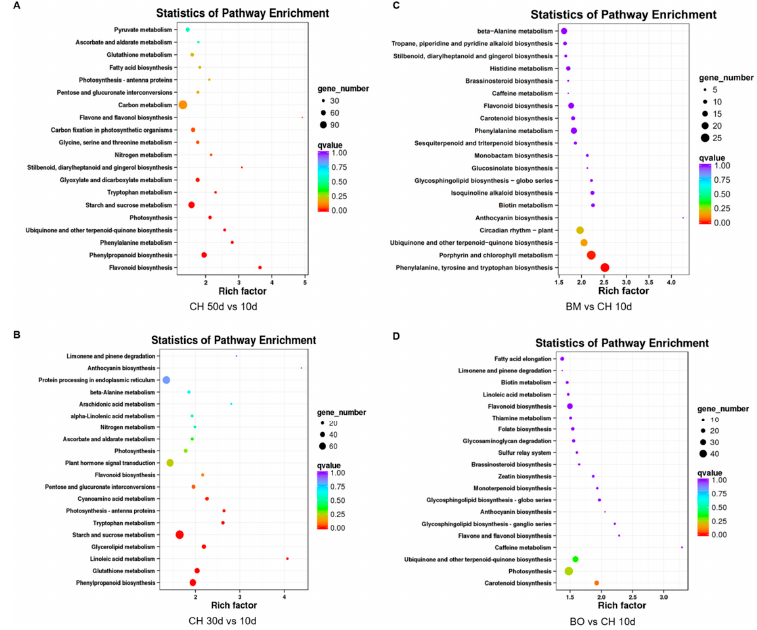
Figure 5. (replaced) Enrichment of KEGG pathways of differentially expressed unigenes (DEUs) in transcriptome comparisons between 50-day and 10-day leaves of CH ( A ), between 30-day and 10-day leaves of CH ( B ), between 10-day leaves of BM and CH ( C ), and between 10-day leaves of BO and CH ( D ).